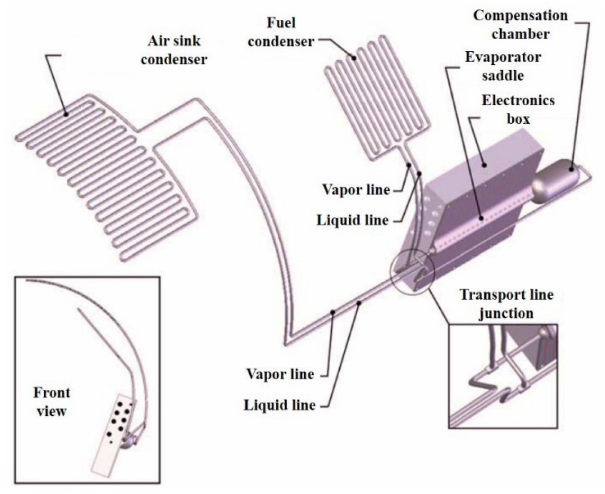
Figure 15. Schematic of the dual-condenser LHP